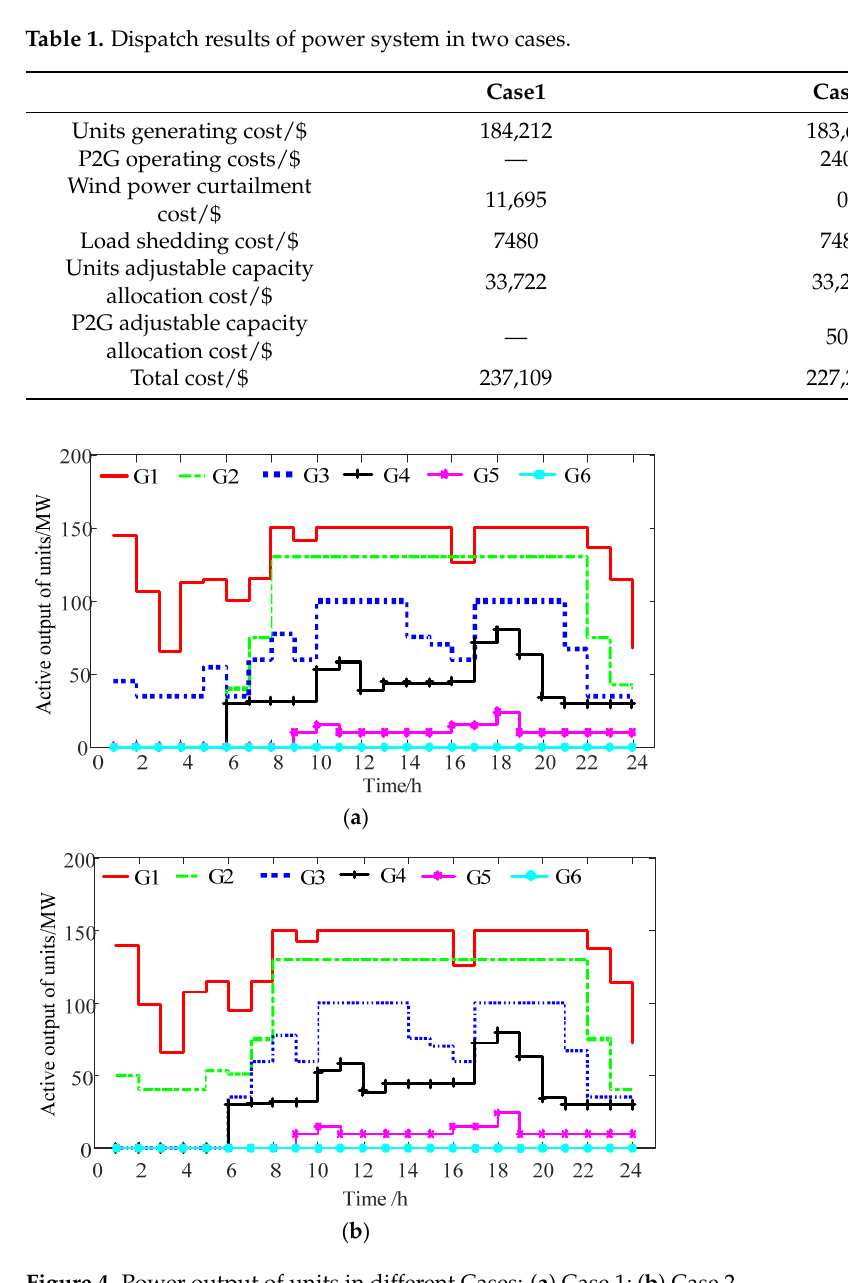
Figure 4. Power output of units in different Cases: ( a ) Case 1; ( b ) Case 2.